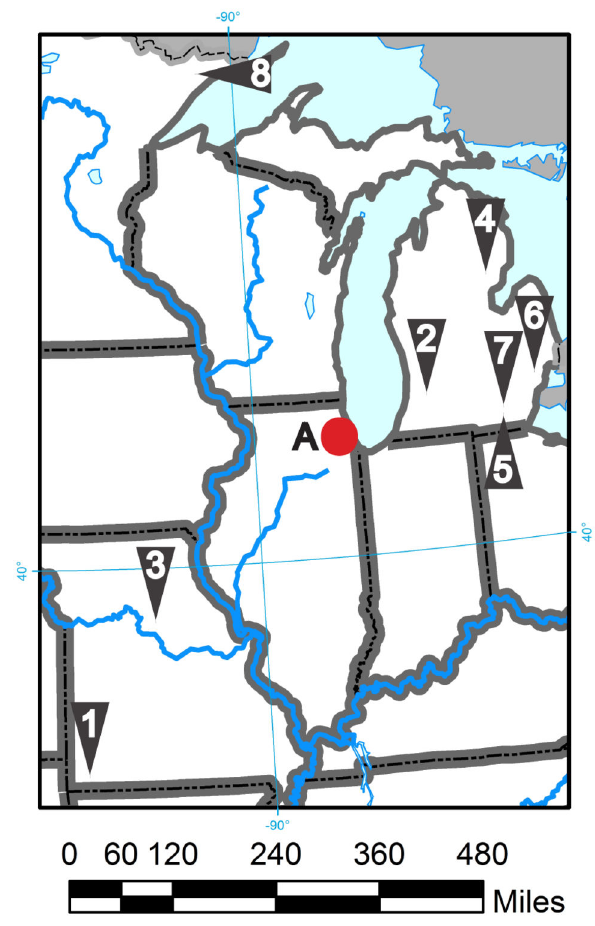
Figure 2. Collection sites for test sediment in the Midwest USA. (1) SR – Spring River, Jasper County, Missouri(2). STJ – St. Joseph River, Michigan(3). P30 – USGS Pond 30 Missouri(4). DOW – Dow Creek Michigan(5). RR2 – Raisin River Site 2, Michigan(6). STM – South Tributary of Mill Creek, Michigan(7). RR3-0 Raisin River Site 3, Michigan(8). WB – West Bearskin Lake Minnesota. Sites are given in order presented in Tables 1-3 and based upon C. elegans survivorship performance. The letter A designates the position of Chicago, IL,